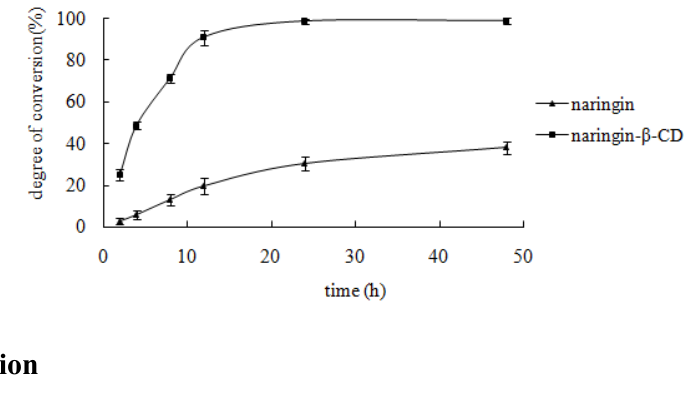
Figure 7. Effect of reaction time. Ten milligrams of substrate, 10 mg snailase, and 1 mL glacial acetic acid and sodium acetate anhydrous buffer (pH 4.5) were mixed in a 1 mL Eppendorf tube. Subsequently, the buffer was incubated in a HH-4 digital constant temperature water bath at 37 °C for 2, 4, 8, 12, 24, and 48 h. Each point represents the mean ± SD ( n =